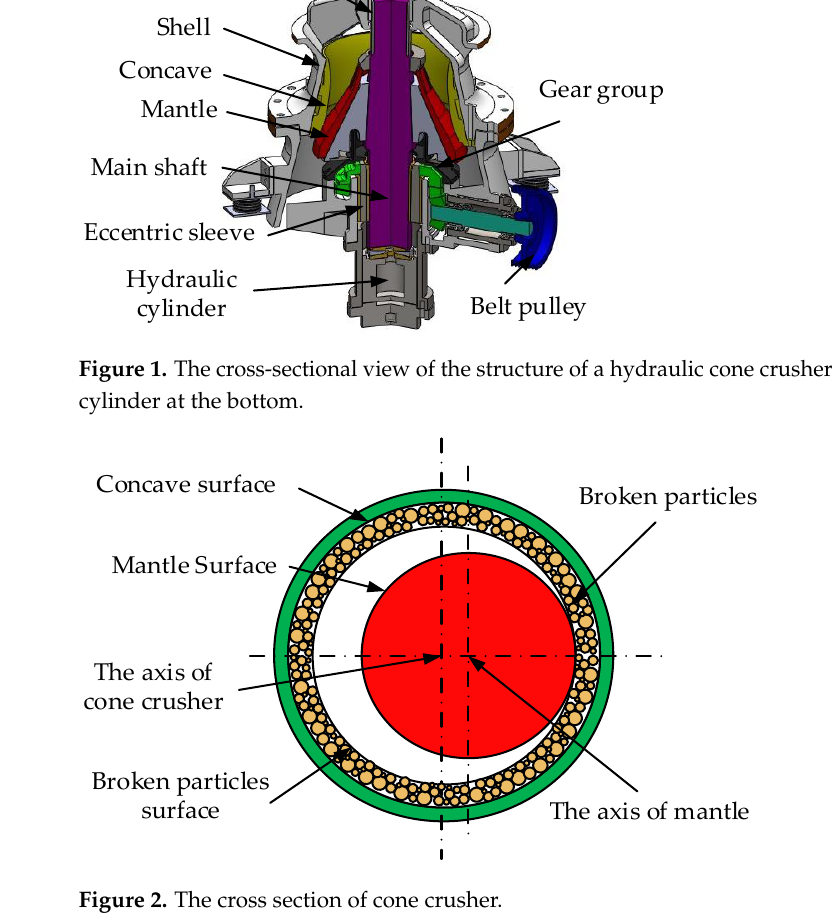
Figure 2. The cross section of cone crusher.